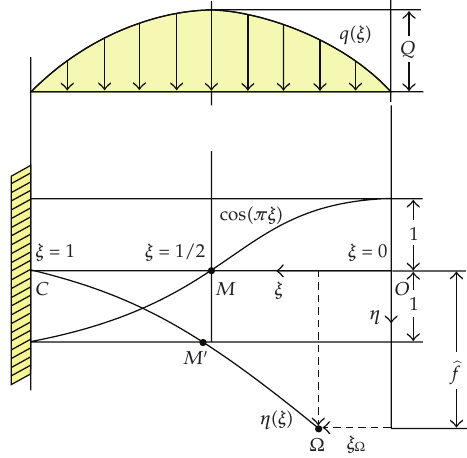
Figure 7: Elastica of a cantilever rod bent by a sinusoidal continuous